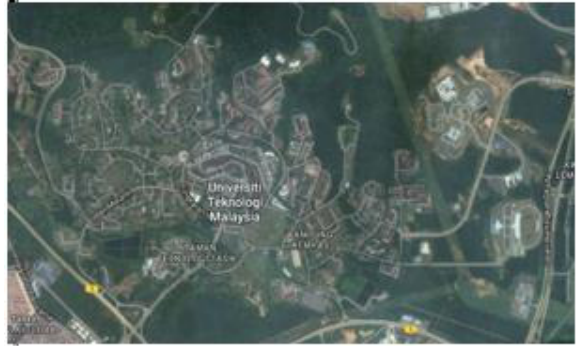
Figure 1. The Map of UTM (Google Maps,